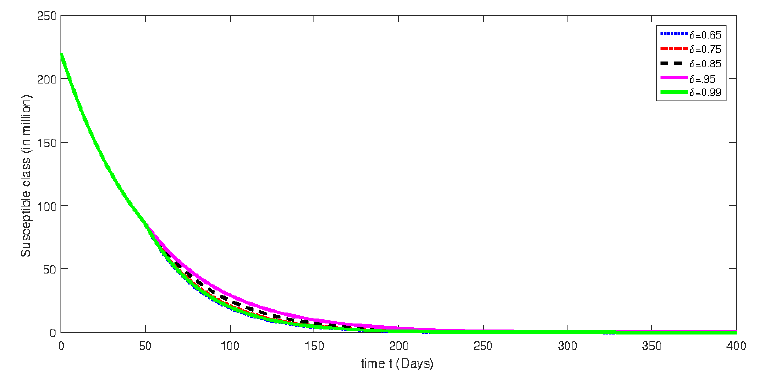
Figure 6. Numerical solution for infected class for the given days and using different fractional orders with isolation rate of 50%.